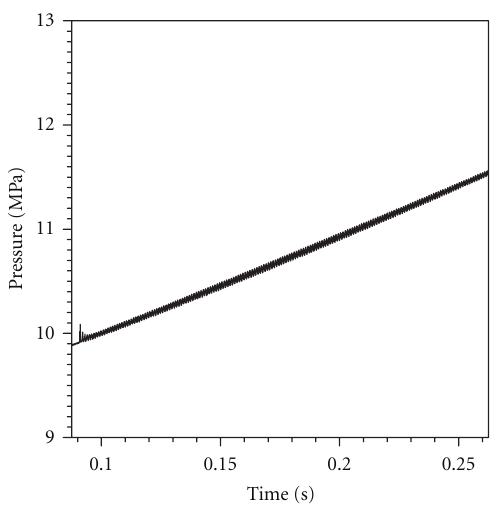
Figure 6: Predicted head-end pressure wave profile, reference motor ( K b = 20000 s − 1 , Δ H s = 150000 J/kg, Δ p d = 2atm, α p = 5%, d m 1 = 10 μ m, d m 2 = 5 μ m, d m 3 = 40 μ m, α p 1 = 1 . 67%, α p 2 = 1 . 67%, α p 3 = 1 . 66% ), three particle sets, acceleration